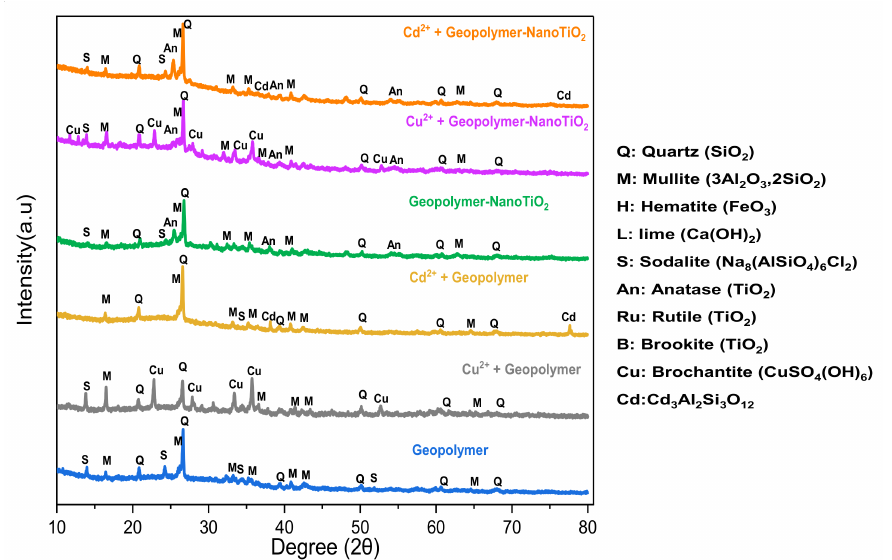
Figure 8. XRD spectra of geopolymer and geopolymer-NanoTiO 2 after adsorption (experimental conditions: volume (15 mL), mass of adsorbent (0.3), pH (6.8), ambient temperature, and stirring speed (250